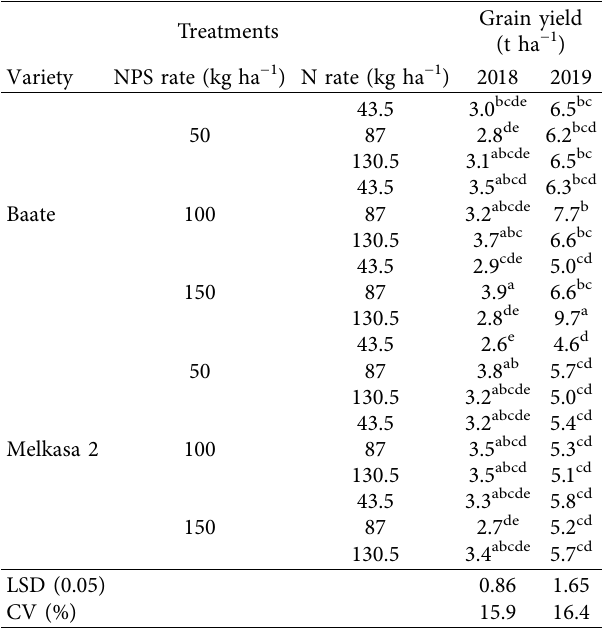
Table 10: Mean values of grain yield as affected by the interaction effect of variety × NPS × N in the 2018 and 2019 cropping